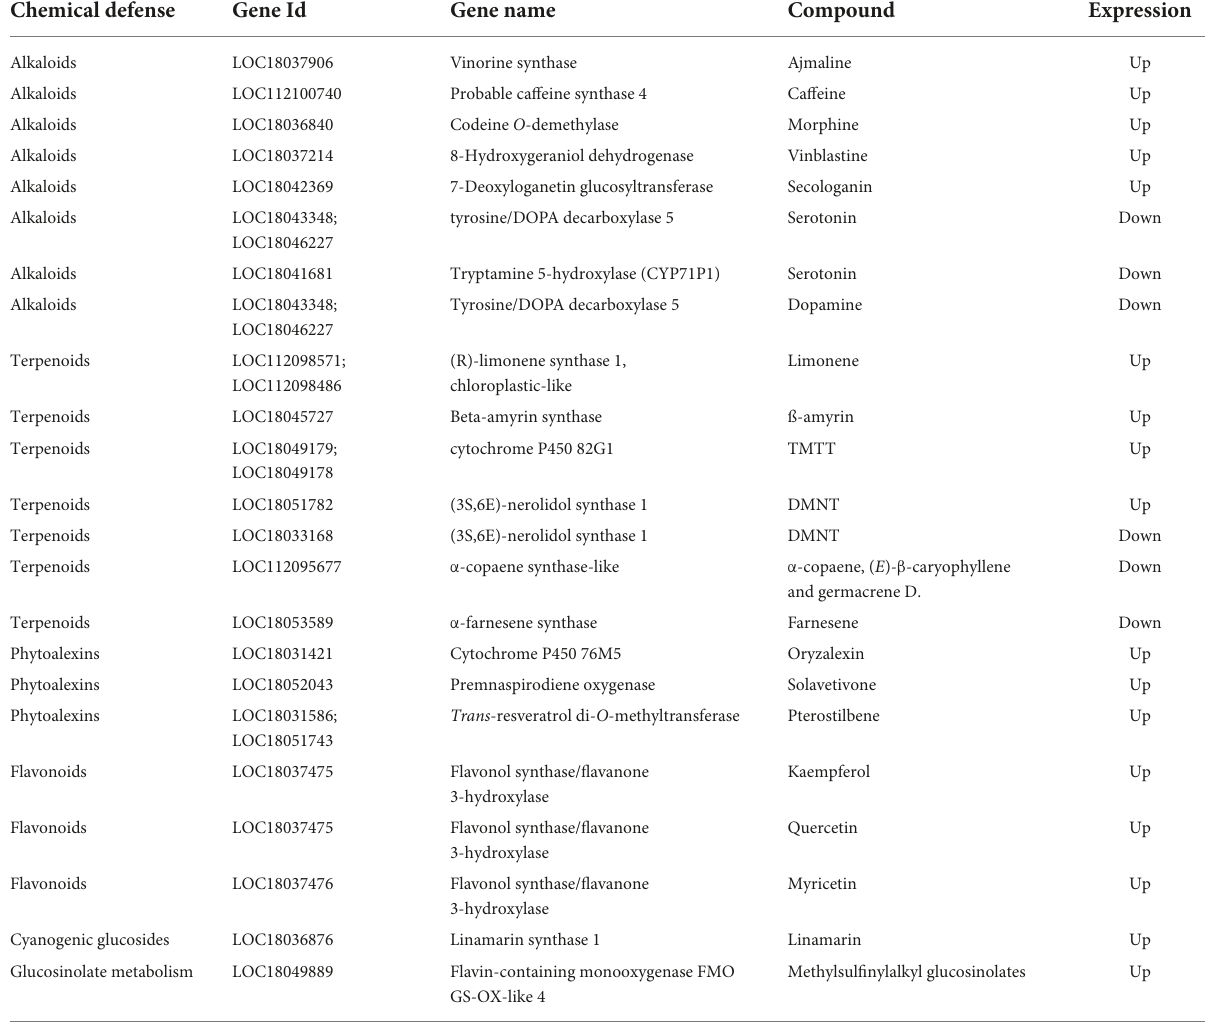
TABLE 1 Expression of genes involved in the biosynthesis of chemical defenses and associated compounds, in the pulp of developing fruitlets of ICH as related to